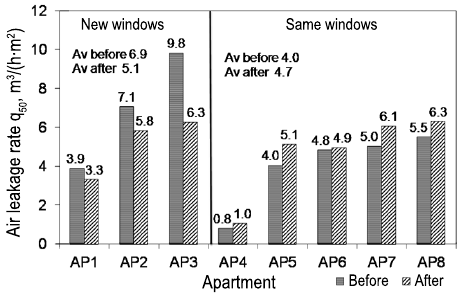
Fig. 7. Results of airtightness before and after renovation with wooden windows that were replaced (left) and existing PVC windows (right)